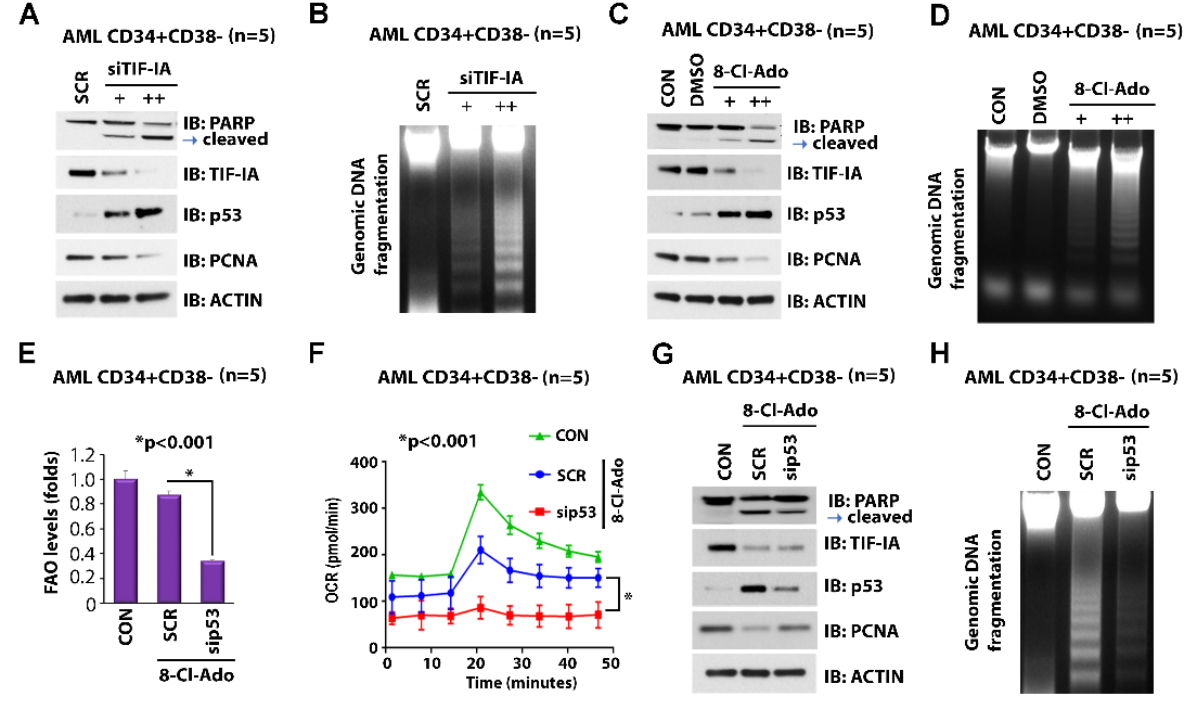
Figure 3. Effects of 8-Cl-Ado on p53 expression and p53-regulated OXPHOS metabolism. ( A , B ) Effects of TIF-IA KD on expression of p53 and PCNA and on apoptosis. LSC-enriched blasts were transfected with siSCR or siTIF-IA [20 nM (+) and 40 nM (++)] for 24 h. ( A ) Each lysate was immunoblotted with the indicated antibodies. ( B ) Genomic DNA was isolated for DNA fragmentation assay. ( C , D ) Effects of 8-Cl-Ado on levels of TIF-IA, p53, PCNA protein and apoptosis. LSC-enriched blasts were treated with DMSO control or 8-Cl-Ado [500 nM (+) and 1 µ M (++)] for 24 h. ( C ) Each lysate was immunoblotted with the indicated antibodies. ( D ) DNA fragmentation assay. ( E , F ) Effects of 8-Cl- Ado on fatty acid oxidation (FAO) and OCR (OXPHOS). LSC-enriched blasts were transfected with siSCR or sip53 (20 nM) for 12 h. The cells were then treated with 500 nM 8-Cl-Ado for additional 24 h. ( E ) Levels of FAO were measured by the oxidation rate of 3 H-palmitic acid. n = 2, in triplicate. ( F ) Levels of oxidative consumption rate (OCR) were measured by seahorse cell energy testing assay. n = 2, in triplicate. ( G , H ) Effects of p53 KD on 8-Cl-Ado-regulated apoptosis. LSC-enriched blasts were transfected with siSCR or sip53 (20 nM) for 12 h. The cells were then treated with 500 nM 8-Cl- Ado for additional 24 h. ( G ) Each lysate was immunoblotted with the indicated antibodies. ( H ) DNA fragmentation assay. CON, control; SCR, scramble siRNA; 8-Cl-Ado, 8-chloro-adenosine. Target sequences for siRNAs are listed in Supplementary Table S2. Original blots see Supplementary File